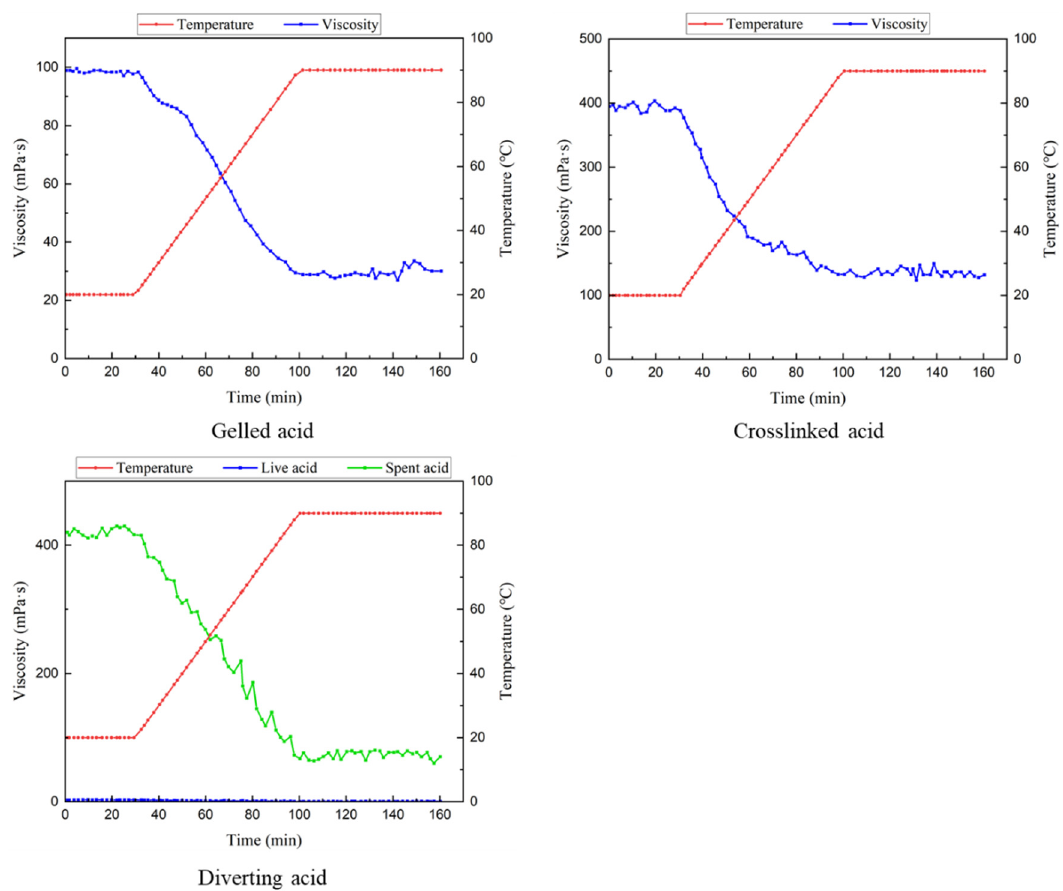
Figure 3. The viscosity of five acid systems at different